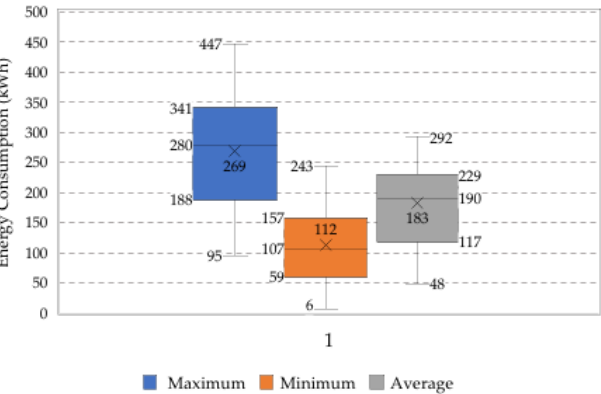
Figure 10. Box-and-whisker plot of maximum, minimum and average monthly residential energy consumption by client under study for the period 2018–2020 (Source: Prepared by the authors). Subsequently, from the average consumption data, the respective consumption and projection graph can be obtained (Figure 11).